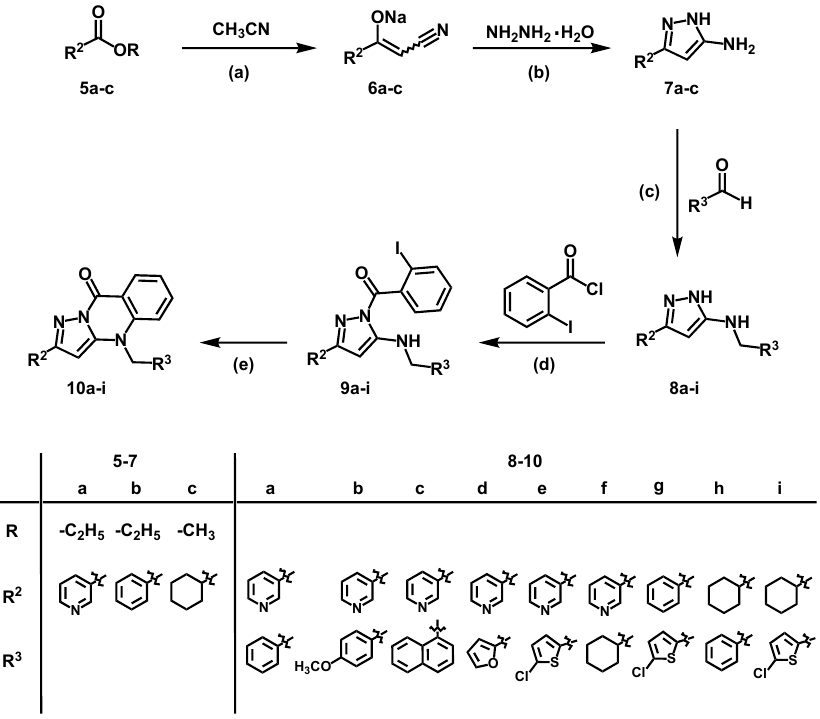
Scheme 1. Synthesis of acylated pyrazoles 9 and pyrazolo[5,1- b ]quinazolin-9(4 H )-ones 10 . (a) NaH,